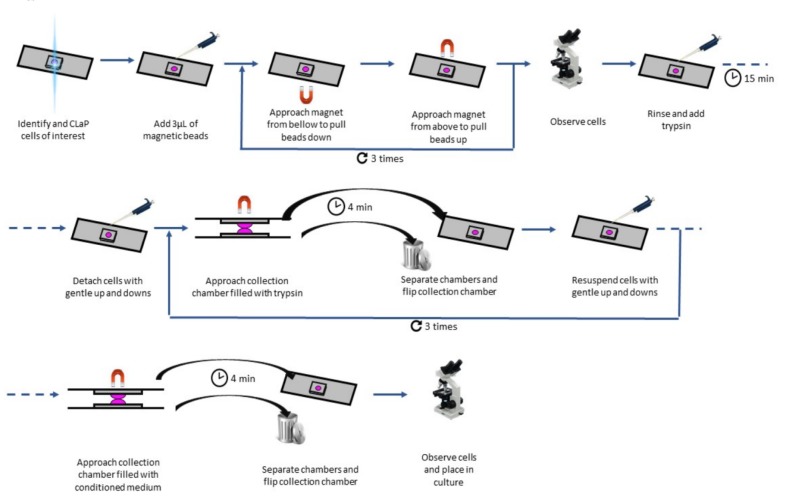
Step by step protocol to tag and isolate cells using scMOCa.